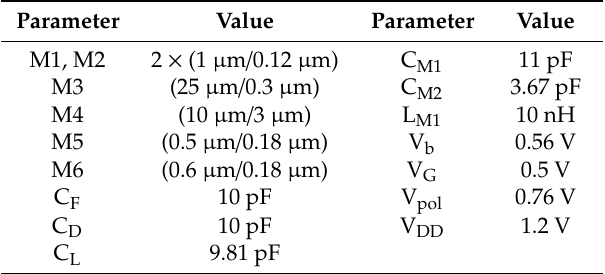
Table 2. Summary of component values for the tuned RFED WuR with active inductor.